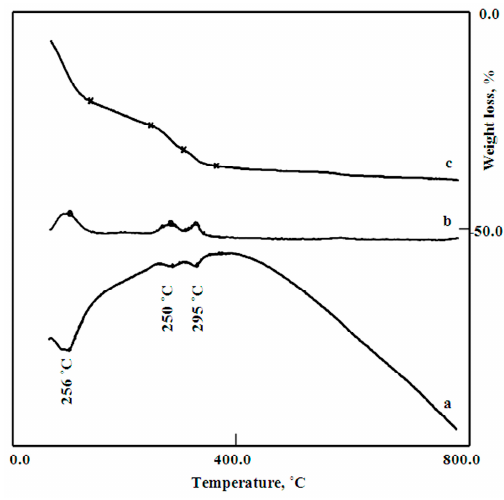
Figure 6. Thermal analyses of Co–Si LDHs after zirconium inclusion: ( a ) DTA, ( b ) DTG, and ( c ) TG.